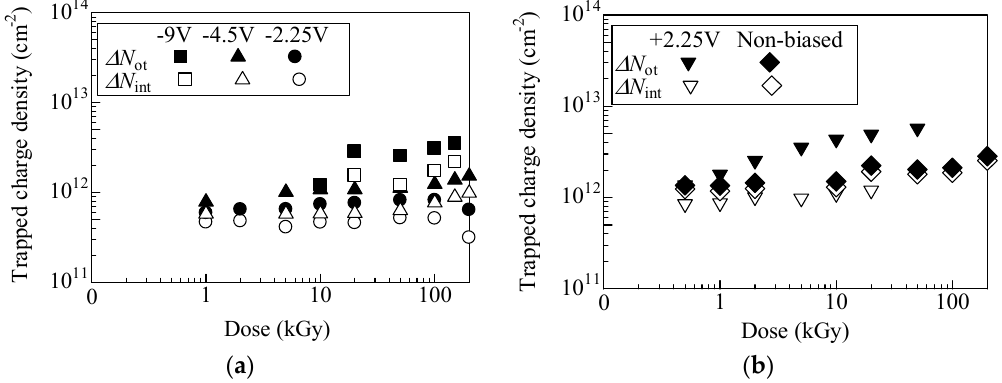
Figure 4. Positive charges trapped in the oxide ( ∆ N ot ) and at the interface ( ∆ N int ) for ( a ) negative biased, ( b ) un- and +2.25 V biased samples.